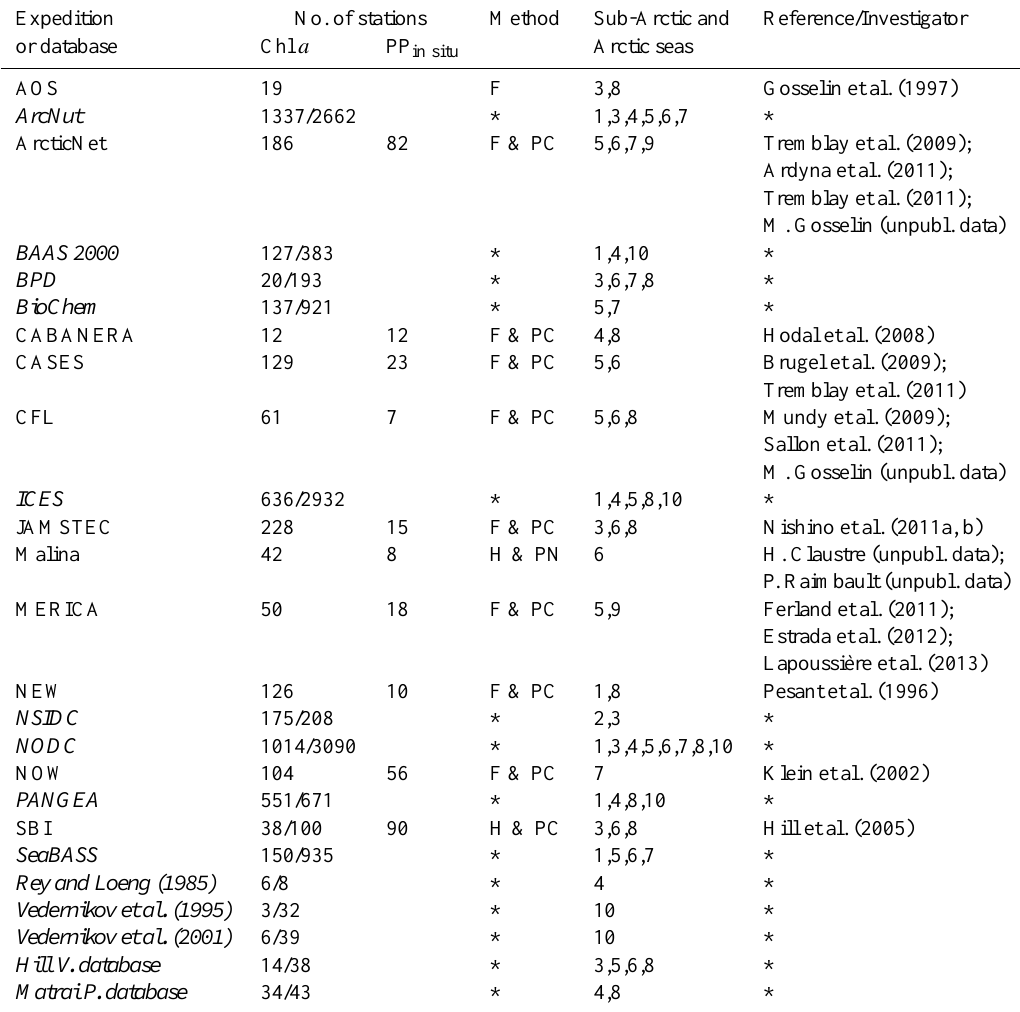
Table 2. Information concerning the expeditions and databases where chlorophyll a (Chl a ) and primary production (PP in situ ) data were obtained for the present study. Expeditions and databases from the ARCSS-PP database (Matrai et al., 2013) are italicized. Processing methods are indicated for Chl a (F represents in vitro fluorometry; H, high performance liquid chromatography, HPLC) and for PP in